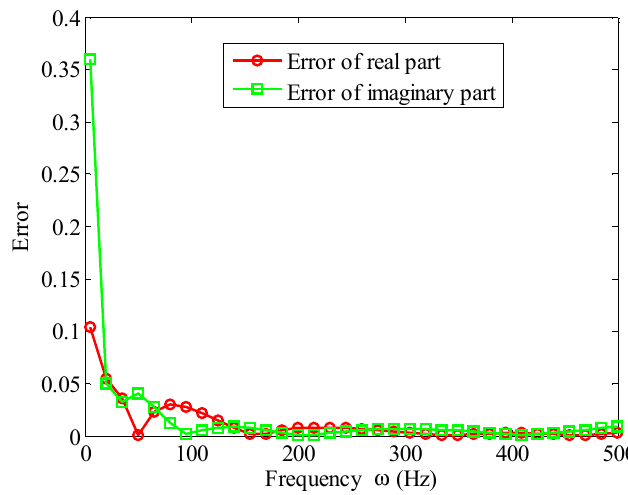
Figure 9. Curve-fitting relative error of the Biot model and the measured values.